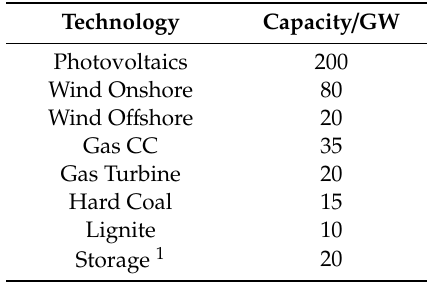
Table 2. Scenario parameters for the technologies in the extended